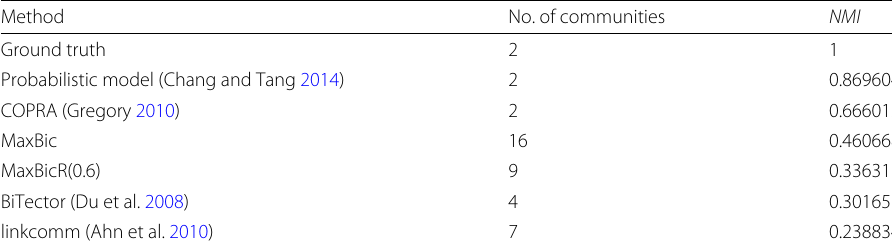
Table 2 Comparison of ground truth with MaxBic, MaxBicR(0.6) and four other methods for detecting overlapping communities of Women ( P ) Method No. of communities